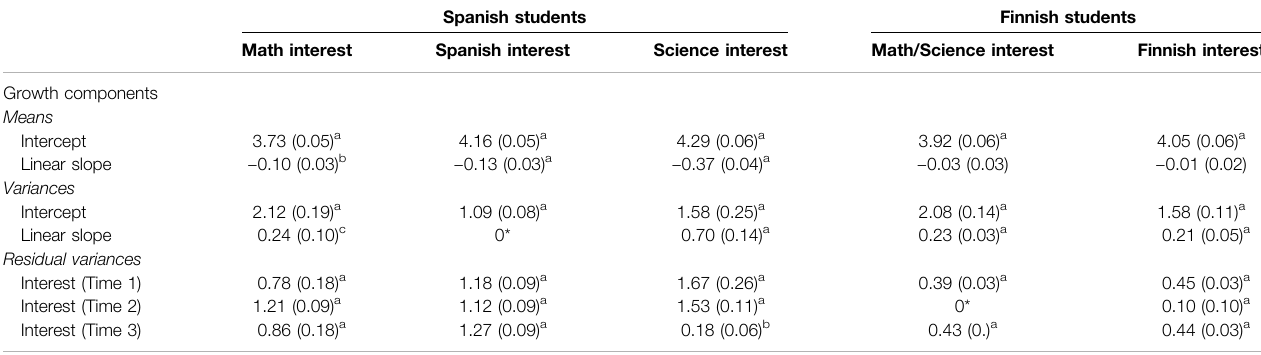
TABLE 3 | Latent growth components of the parallel process LGC model (standard errors in the parentheses).